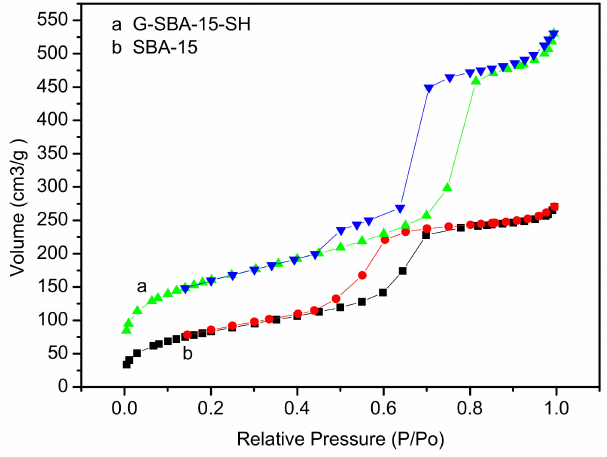
Figure 5. N 2 adsorption isotherms of mesoporous SBA-15 and